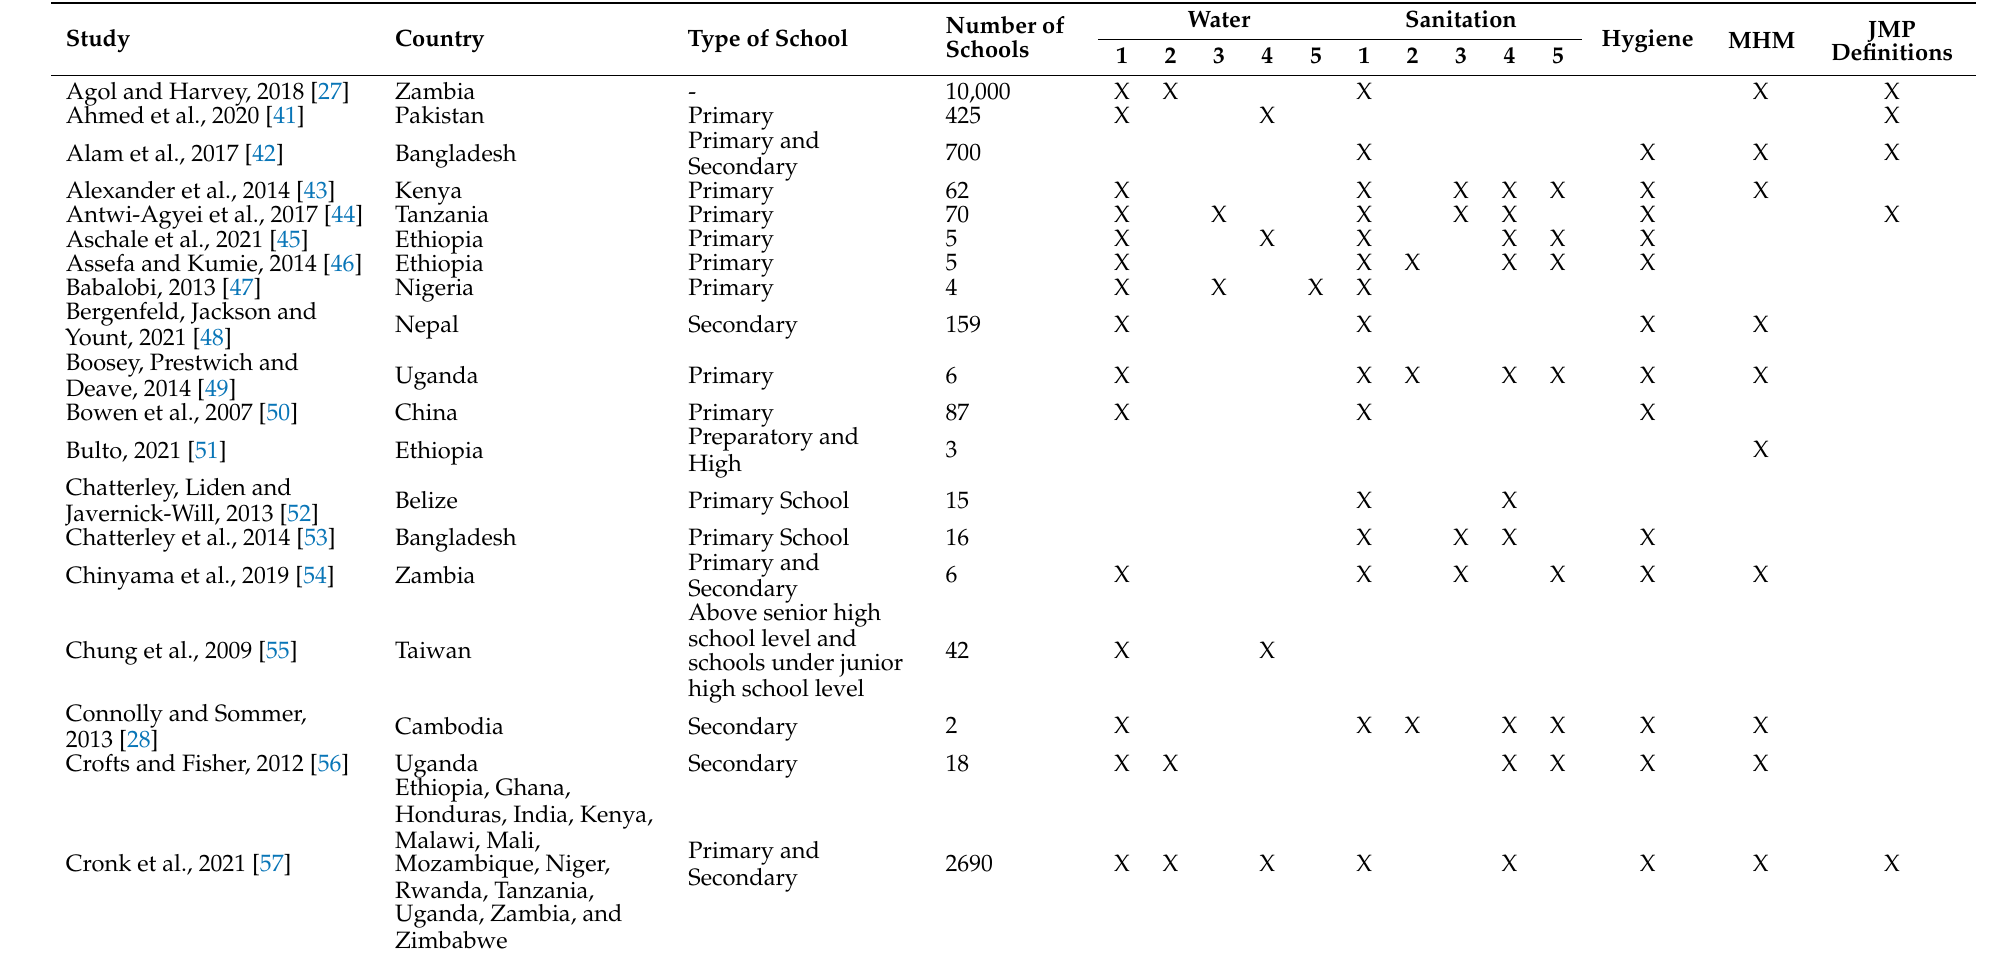
Table 3. Description of the 65 studies included in the systematic